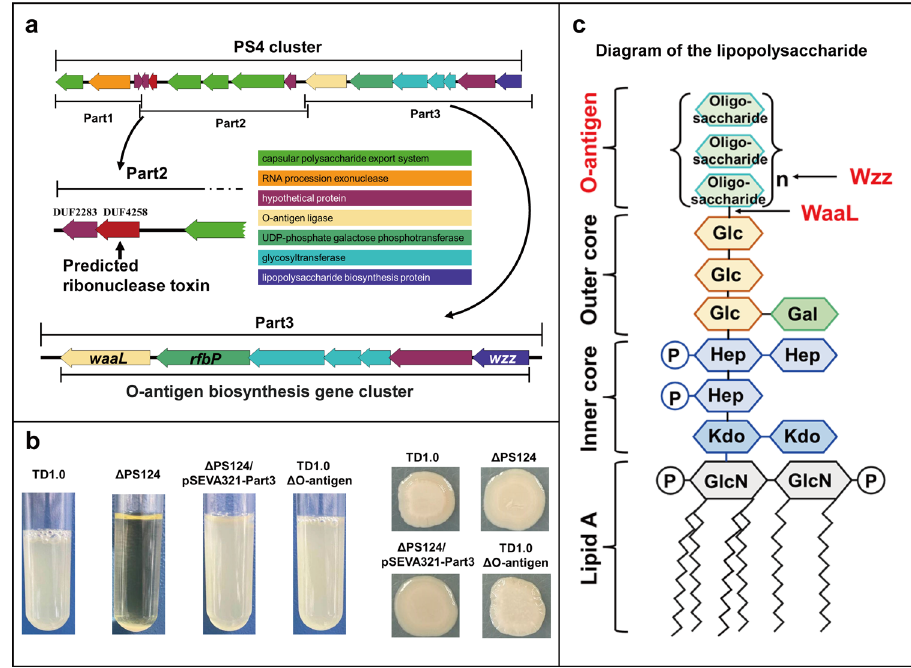
Fig. 6 De fi ciency of O-antigen is the key factor of self- fl occulation. a O-antigen biosynthesis genes in the PS4 cluster. b Self- fl occulation of TD1.0, Δ PS124, Δ PS124/pSEVA321-Part3 and Δ O-antigen after standing for 30 min and their mucoid/dry phenotype. The strains were cultured in LB60 medium for 24 h and used for self- fl occulation test (left). Morphology of TD1.0, Δ PS124, Δ PS124/pSEVA321-Part3, and Δ O-antigen cultured on LB60 agar plate (right). TD1.0, H . bluephagenesis TD1.0; Δ PS124, H . bluephagenesis TD1.0 with deletion of PS1, PS2, and PS4 gene clusters; Δ PS124/pSEVA321-Part3, Δ PS124 complemented with Part3 of the PS4 cluster; Δ O-antigen, TD1.0 with deletion of the 7 genes in Part3. c Diagram of the structure of lipopolysaccharide (LPS) in E . coli 28 . The action positions of WaaL and Wzz are depicted with arrows. GlcN, N-acetylglucosamine; Kdo, 3-deoxy-D-manno- octulosonate; Hep, heptose; Glc, glucose; Gal, galactose; Oligosaccharide, oligosaccharide unit of O-antigen; P, phosphate